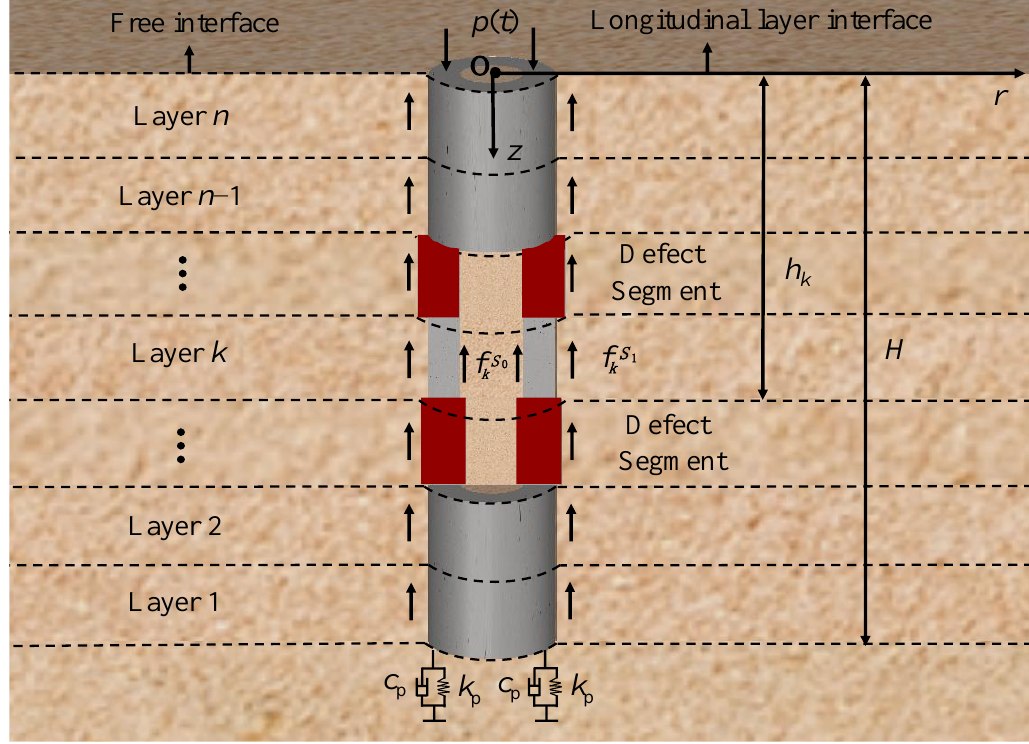
Figure 1. Simplified mechanical model.